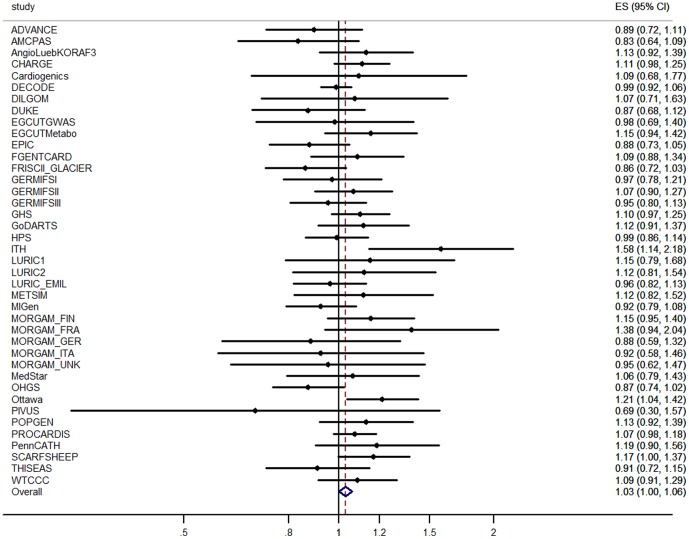
Forest plot for independent replication of association between rs4149313 and CAD in CARDIoGRAMplusC4D.Fixed-effect meta-analysis was applied for effect of rs4149313 on CAD in CARDIoGRAMplusC4D consortium. The diamond in the bottom represents the confidence interval of this independent replication.